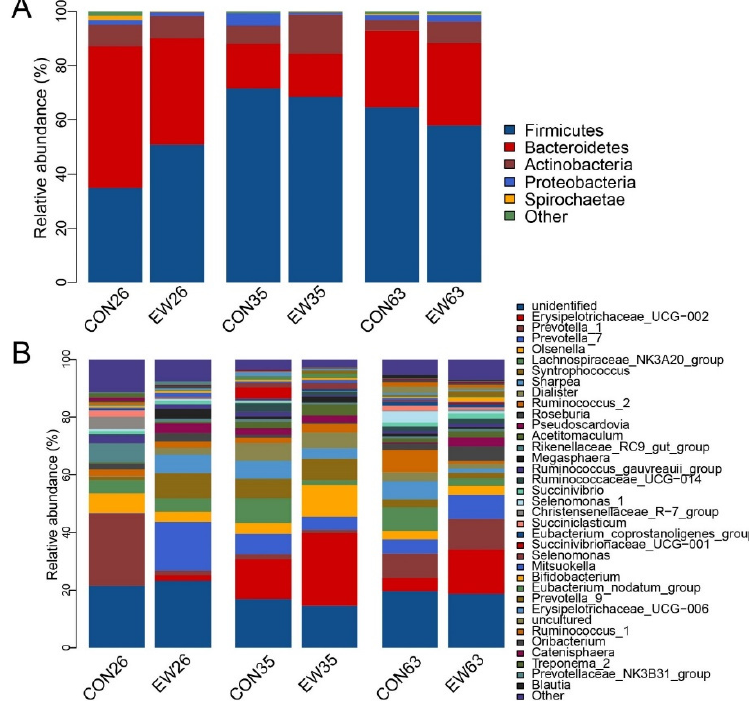
Figure 2. The composition of rumen microbiome at phylum and genus level. ( A ): The composition of rumen microbiome at phylum level; ( B ): The composition of major rumen genera. CON26 = con- trol at 26 d; EW = early weaning group at 26 d. The rest can be deduced by analogy.